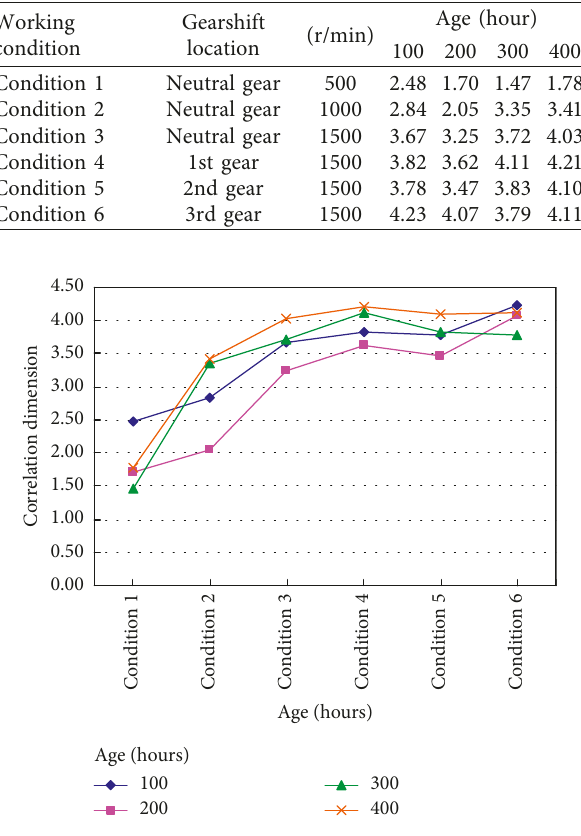
Figure 20: Diagram of dimensions, age, and working